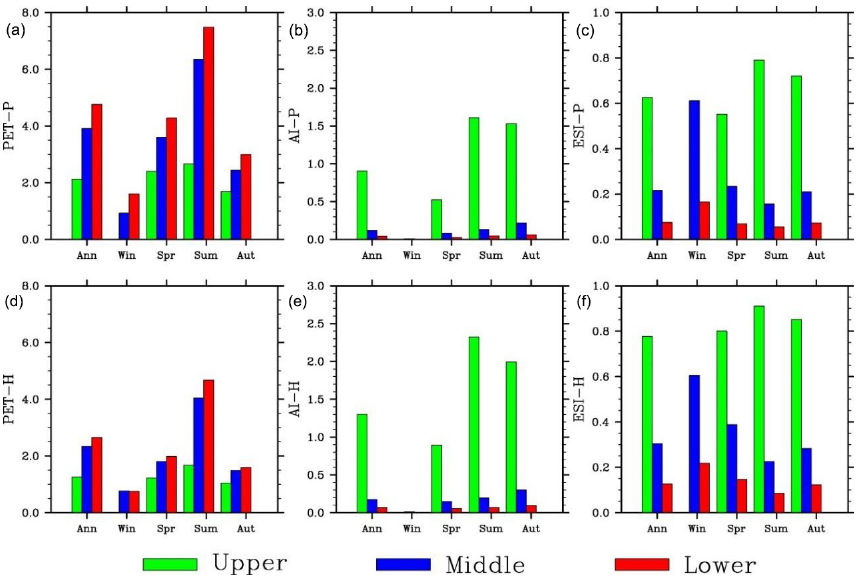
Figure 8. Seasonal variations of the simulated potential evapotranspiration (mmd − 1 ), aridity index, and evaporative stress index (from left to right). Panels (a) – (c) and (d) – (f) are for the Penman–Monteith and Hamon method, respectively.